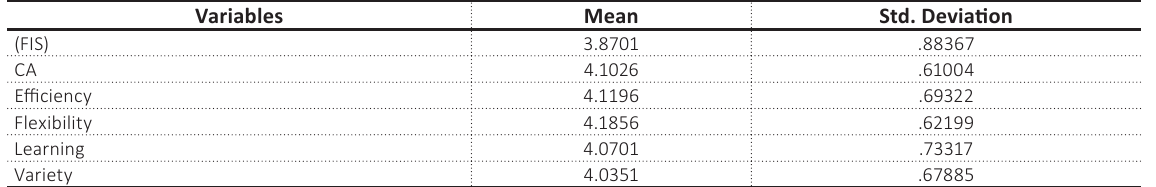
Table 3. Descriptive statistics of